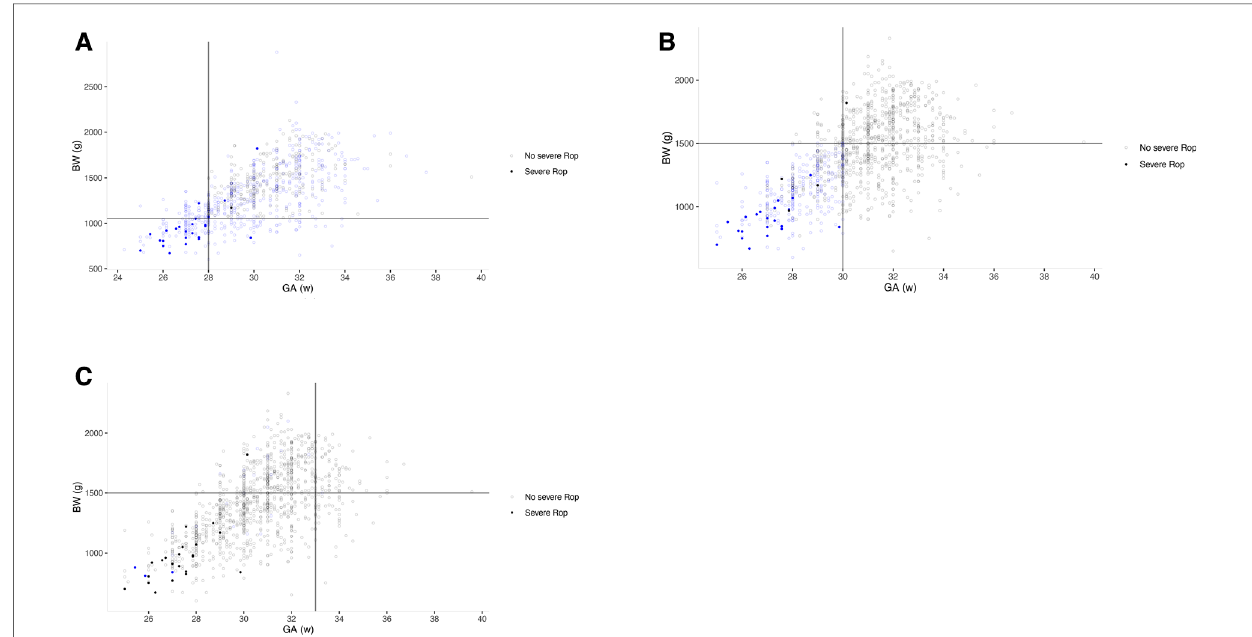
FIGURE 2 Three scatter plots based on gestational age (GA) and birth weight (BW) of infants in three populations. Empty circle means infants with severe ROP, and fi lled circle means infants without severe ROP. Circles color-coded by blue were infants included by each model. The lines de fi ne the thresholds for BW and GA in different models. ( A ) G-ROP for severe ROP; ( B ) high-grade Co-ROP for severe ROP; ( C ) High grade Alex-ROP for severe ROP.